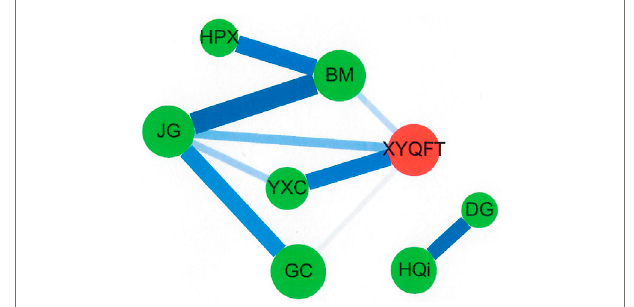
FIGURE4| CHMnetworkanalysisinpatientswithHHAs.Herbalformula isshownastheredcircle,andsingleherbisexpressedasthegreencircle.The circle size indicates prescription frequency of the CHM. The linesize and color representthesupportvalueandliftvaluebetweenpairedCHMproducts, respectively. The thicker and darker connection line shows the stronger strength of connection between the paired CHM products. Abbreviations: HHAs, hereditary hemolytic anemias; CHM, Chinese herbal